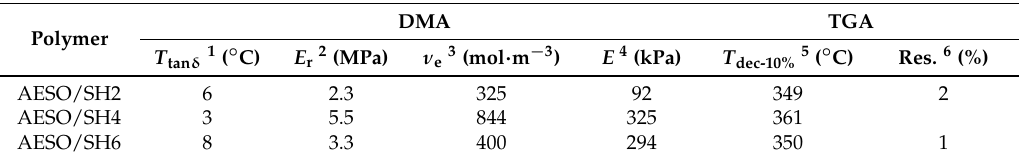
Table 2. Thermal and dynamic mechanical analysis data of cross-linked polymers.